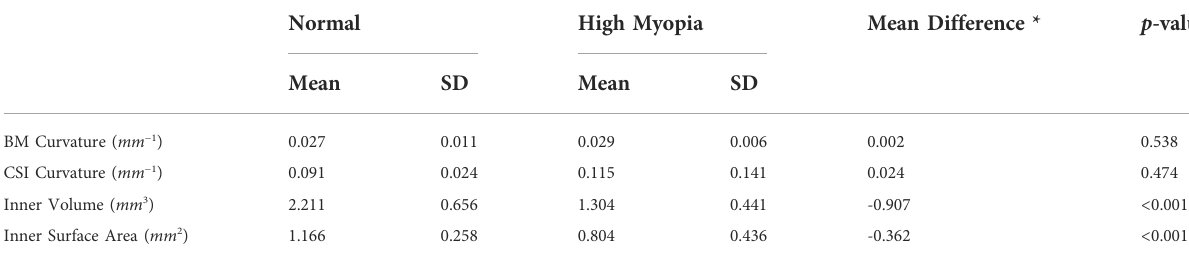
TABLE 4 Results of choroidal 3D features in normal and highly myopic